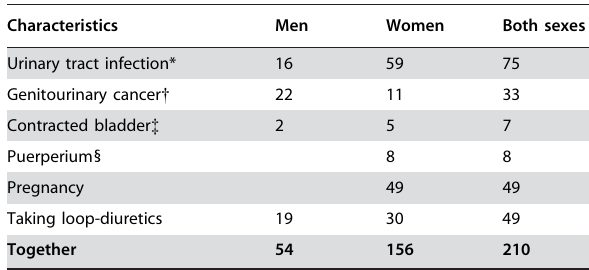
Table 2. Exclusions of the study population of overactive bladder analysis: number of excluded subjects among